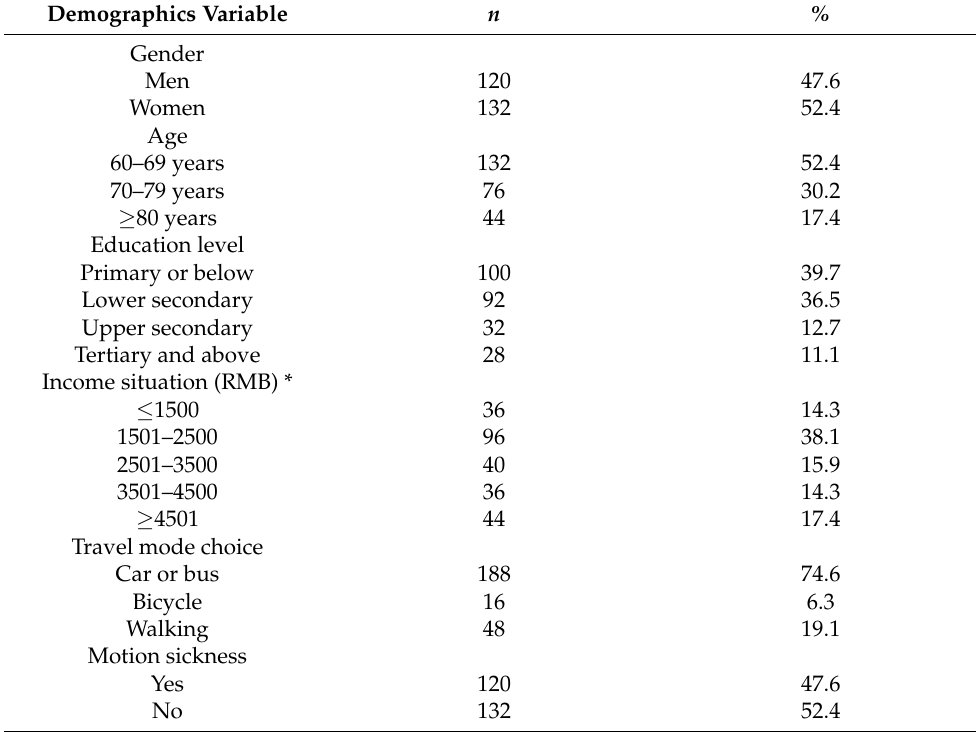
Table 1. Demographics of the participants in the city of Yiwu ( n =